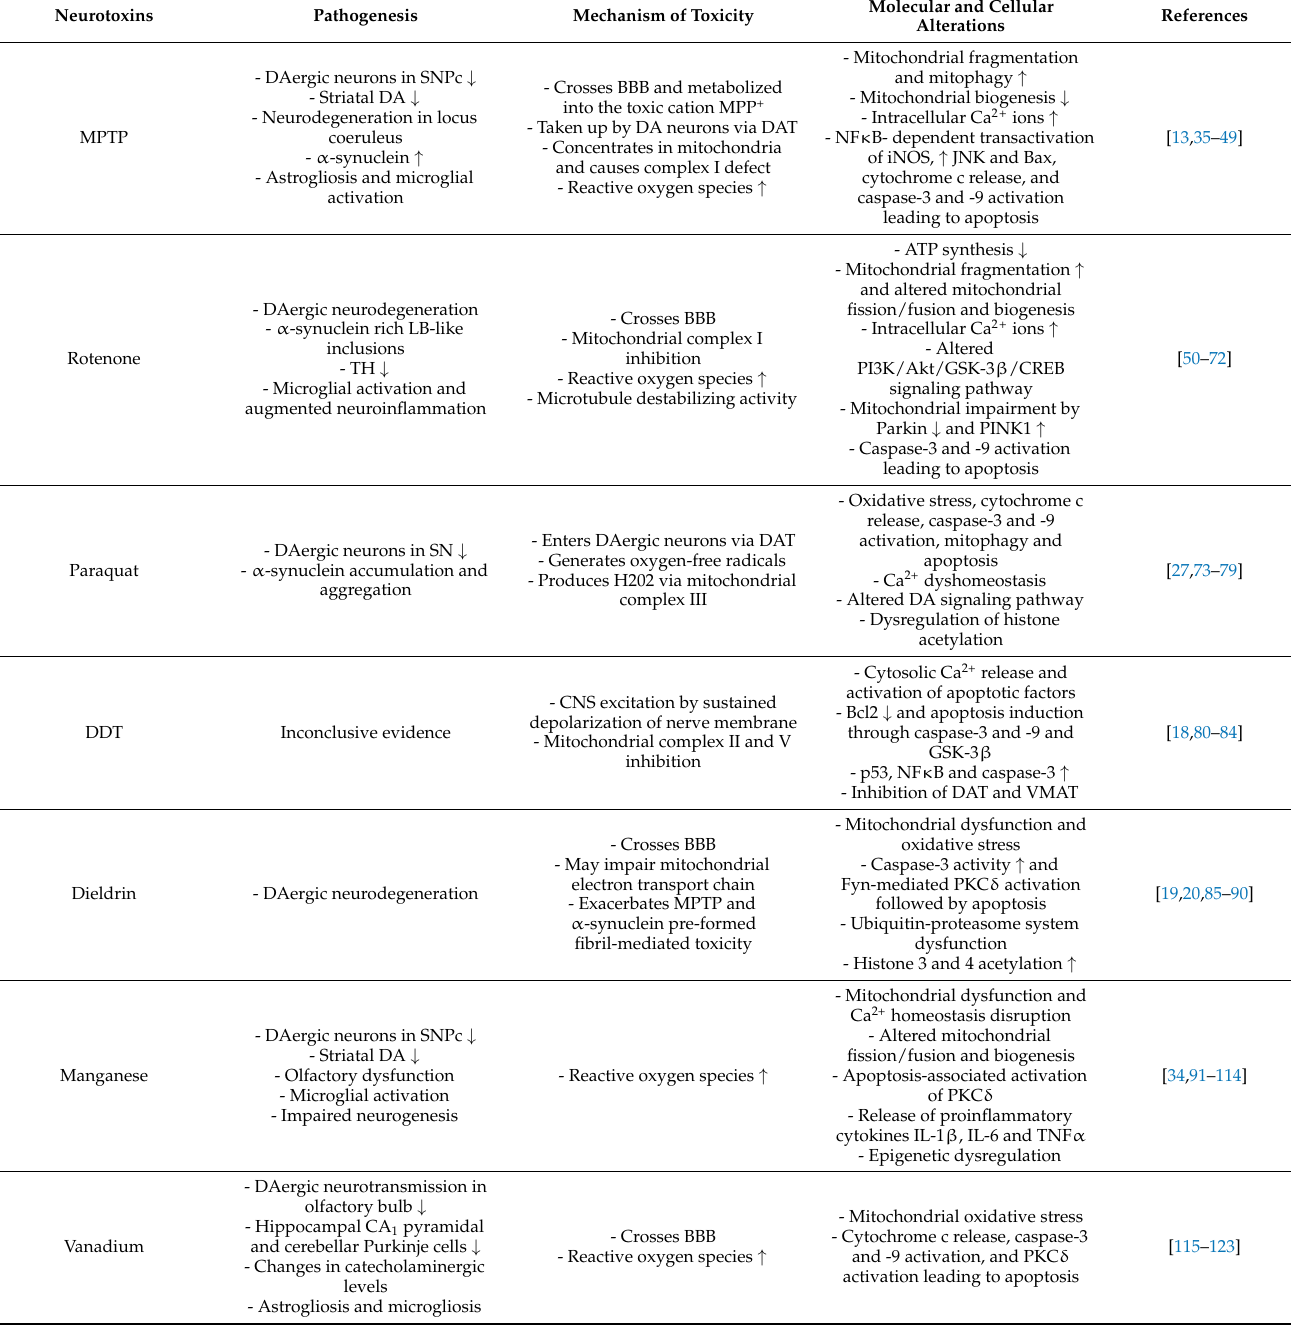
Table 1. Summary of the role of environmental risk factors in Parkinson’s